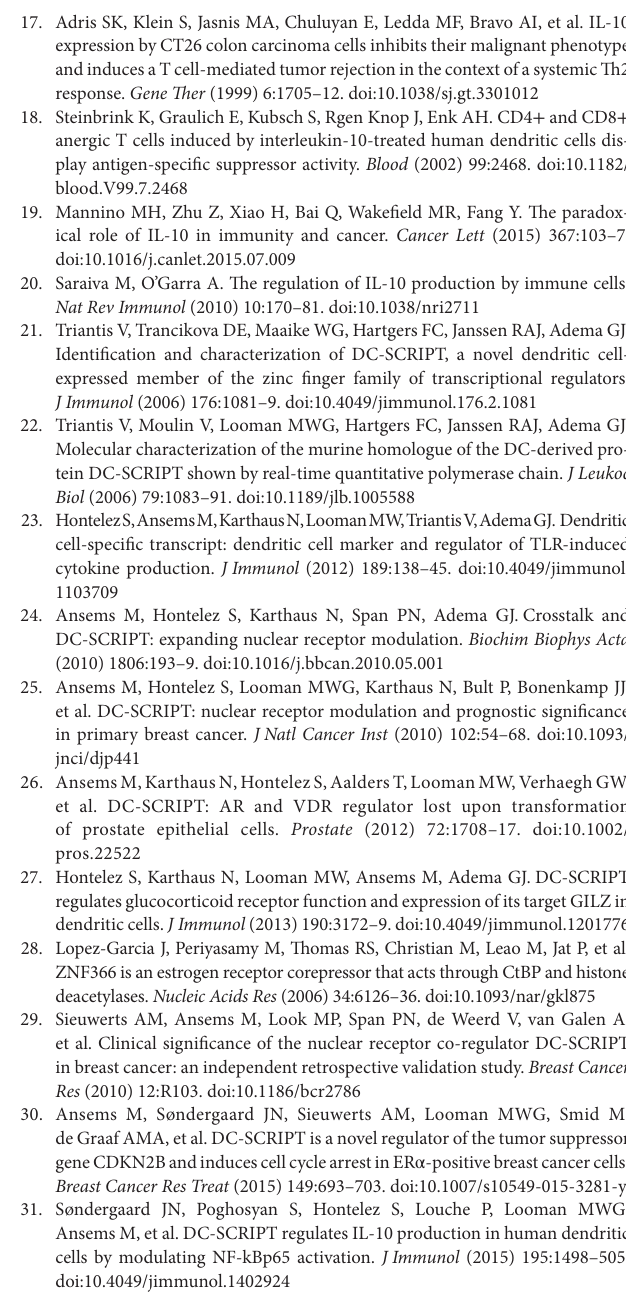
TaBle s1 | GREAT analysis, GO Biological Process. TaBle s2 | GREAT analysis, GO Molecular